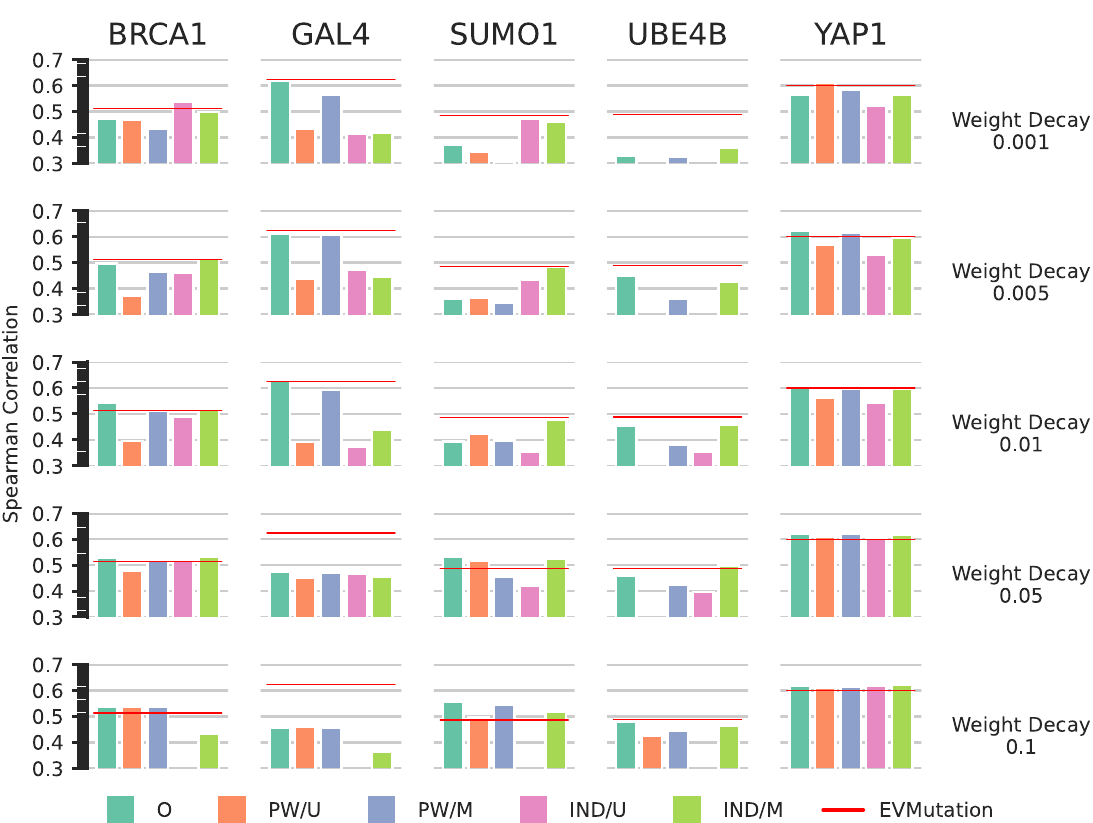
Fig 4. Spearman correlation with experimental data of original (O) and extracted models (PW/U, PW/M, IND/U, IND/M) for VAE models. Shown is the Spearman rank correlation between the experimental data and the energies of the original model (O), the energies of the pairwise and independent models extracted using samples from a uniform distribution (PW/U and IND/U), and the energies of the pairwise and independent models extracted using sequences sampled from the original model distribution (PW/M and IND/M). The rows correspond to different weight decay settings in the original model, as indicated on the